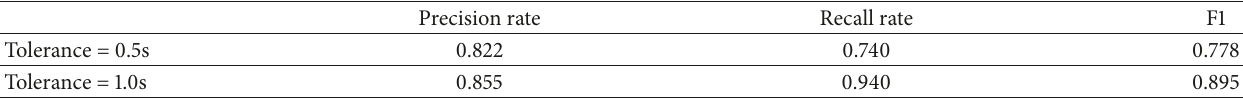
Table 2: Experimental results of audio announcement detection.